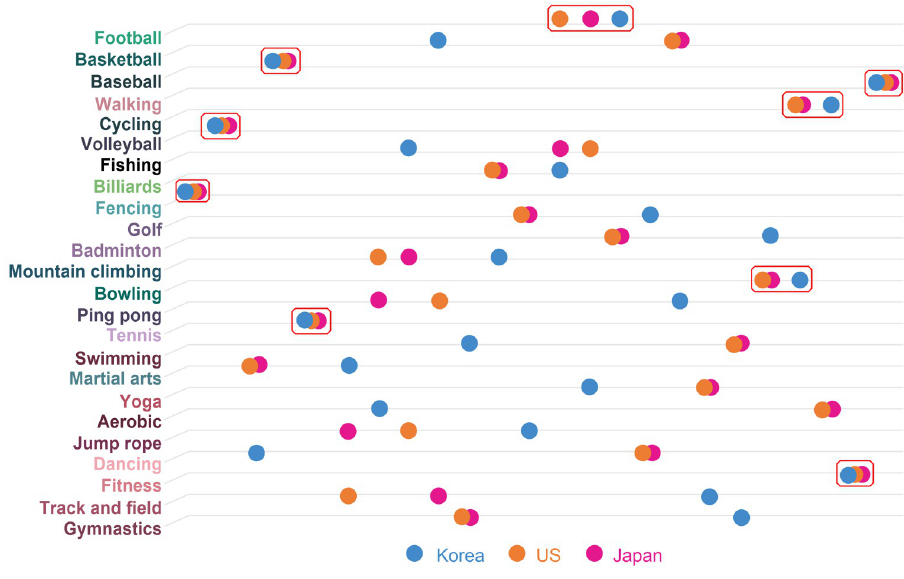
Fig 13. Comparison with